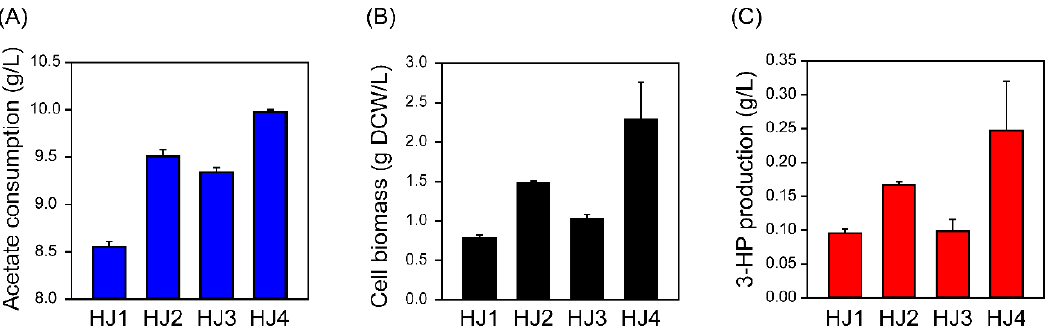
Figure 3. Genetic engineering to improve 3-HP production from acetate. Acetate consumption (g/L), cell biomass (g DCW/L) and 3-HP (g/L) production of the HJ1—4 strains after 48 h of fermentation. ( A ) Acetate consumption (g/L), ( B ) cell biomass (g DCW/L), and ( C ) 3-HP production (g/L) of engineered strains were compared. The error bars indicate standard deviations for measurements from three independent cultures.